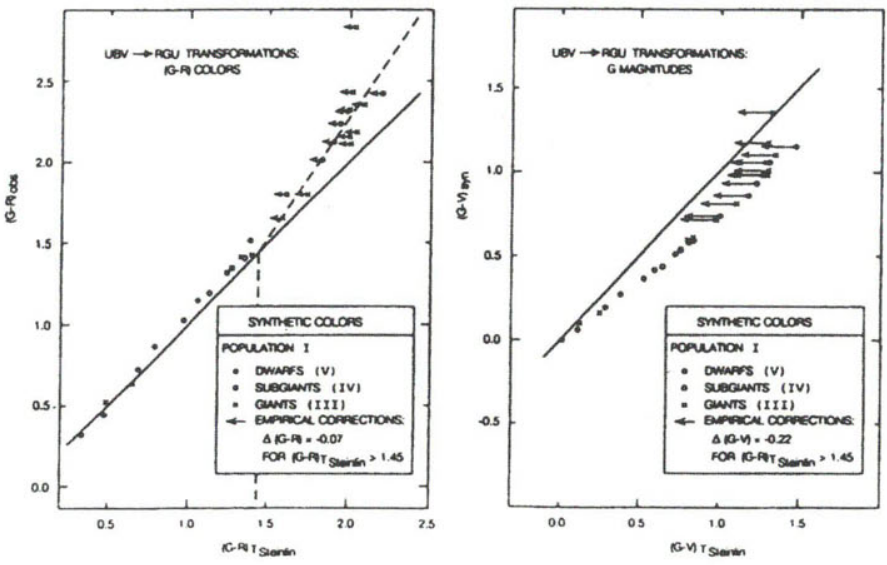
Fig. 12a. Color equation (dashed line) between observed (ordinate) and transformed (abscissa) G-R colors of several hundred stars in the original catalogs of two Basel high-latitude fields with photographic data available in both UBV and RGU systems (Buser 1988). Fig. 12b. Color equation between G magnitudes transformed from UBV according to Steinlin (1968), and those synthesized from the stel- lar flux spectra library. Empirical corrections for red stars, introduced by Becker and Fenkart (1976), have been added to demonstrate partial recovery of intrinsic colors (solid line with slope 1) in the original Basel catalog data.